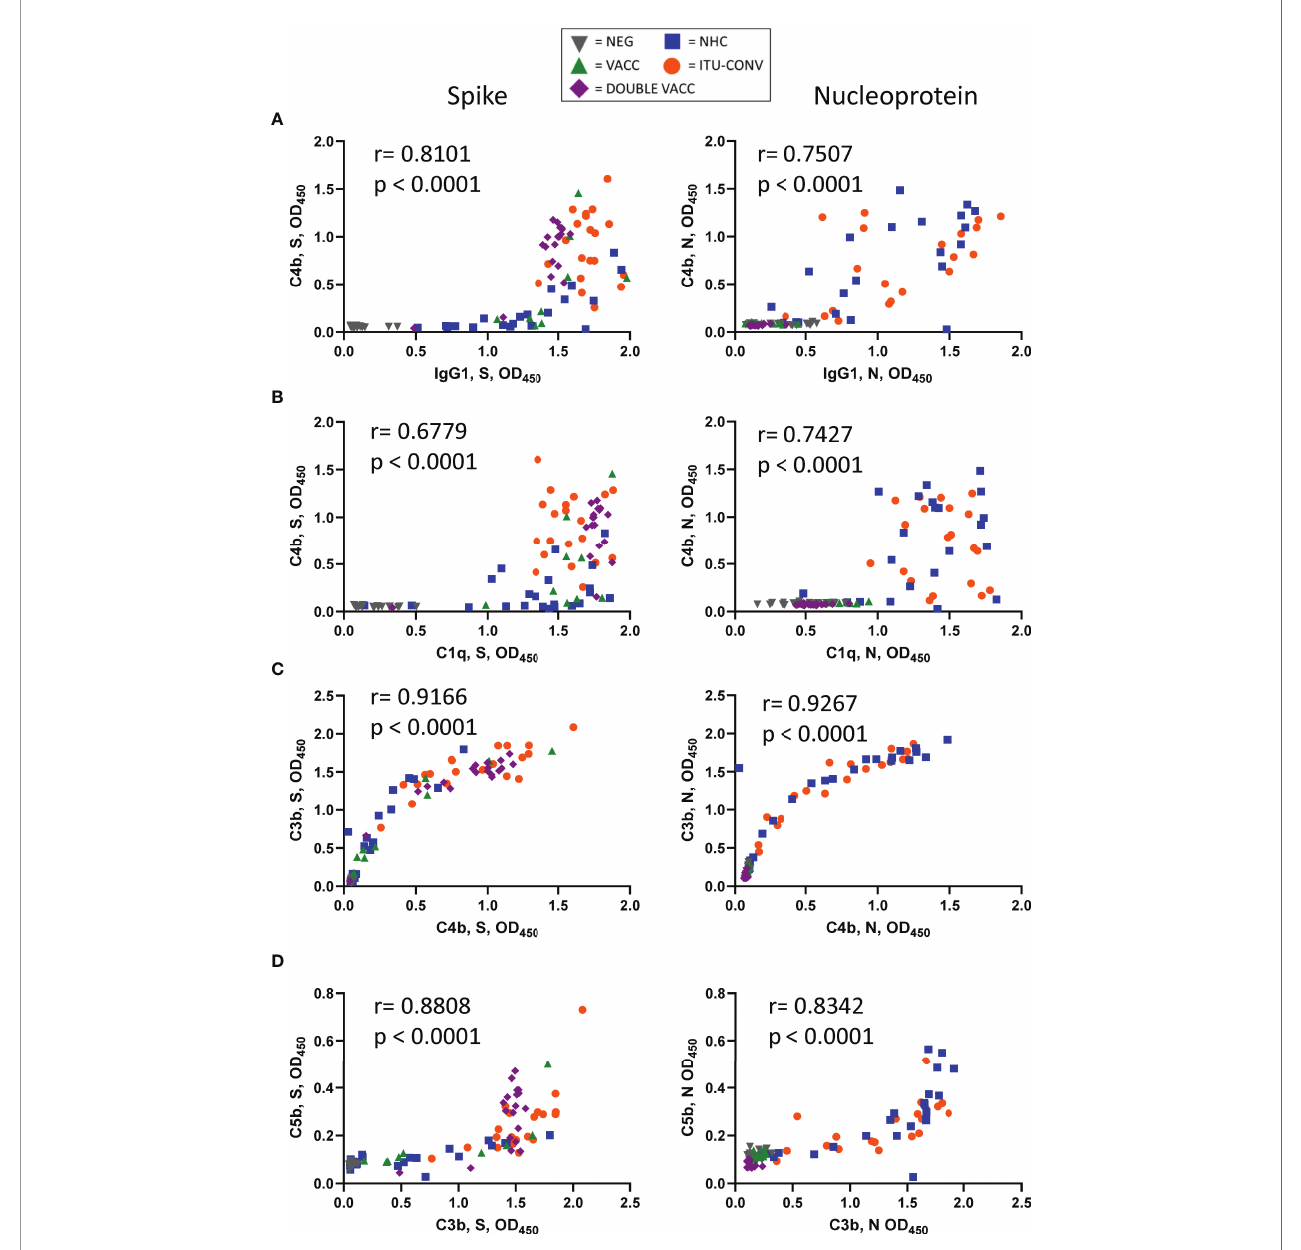
FIGURE 4 | Threshold levels of IgG1 associate with the detection of C4b. (A) XY scatter plots for C4b responses and IgG1 responses, (B) C4b and C1q, (C) C3b and C4b and (D) C5b and C3b against S (left) or N (right). XY pairs, n ≥ 91, each point represents one serum. Correlations were determined using the Spearman's rank correlation test (r and p values